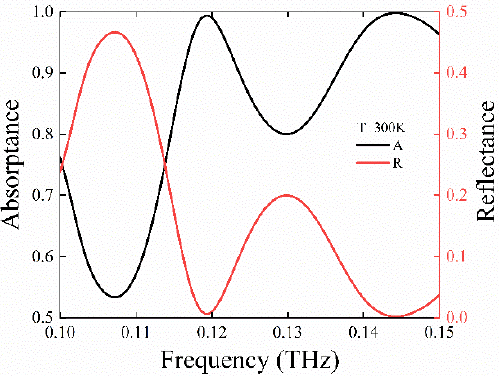
Figure 6. The simulated absorptance and reflectance for U at a frequency ranging from 0.1 to 0.15 THz. The temperature is T = 300 K.